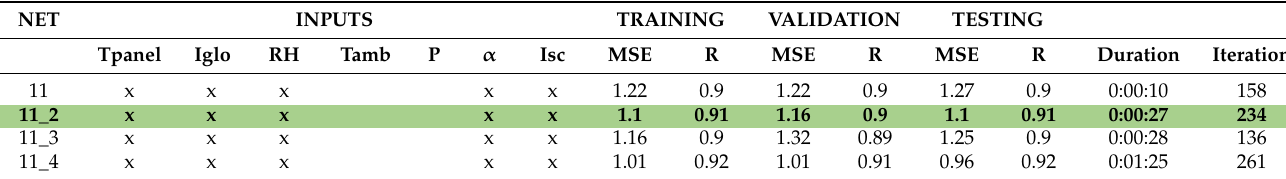
Table 6. ANN Model 2 results with more than 10 neurons.